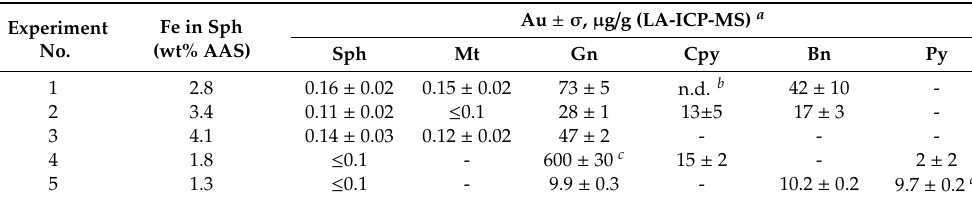
Table 2. Au content in minerals determined by laser ablation inductively coupled plasma mass spectrometry (LA-ICP-MS); Fe content in sphalerite by atomic absorption spectrometry; coexisting minerals were synthesized in hydrothermal experiments at 450 ◦ C and 1